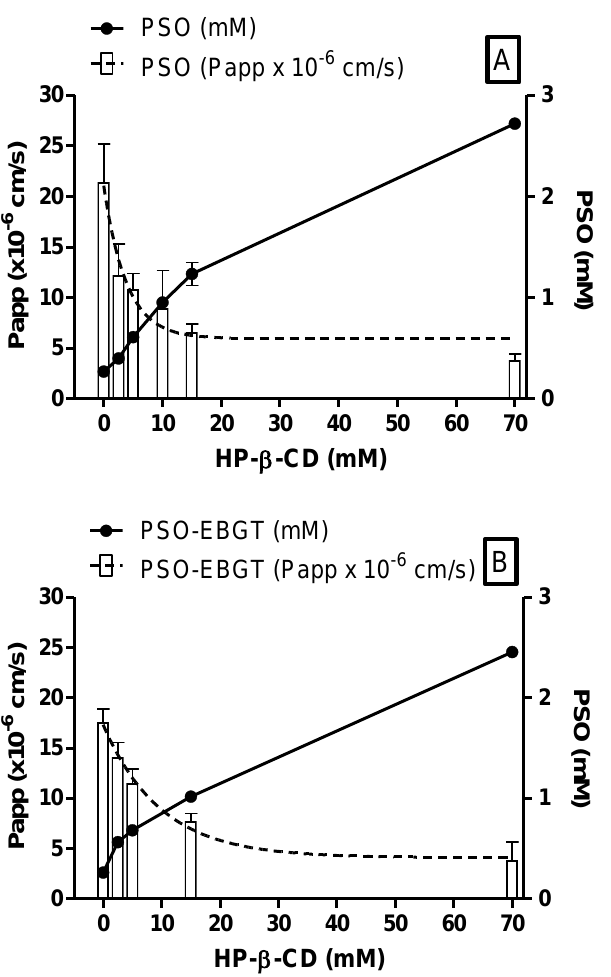
Figure 9. Ex vivo P app and solubility of PSO standard ( A ) and PSO EBGT marker ( B ) as a function of increasing HP- β -CD concentration. P app shown as mean ± SD ( n = 6) and expressed as × 10 –6 cm/s; solubility shown as mean ± SD ( n = 3) and expressed as mM.